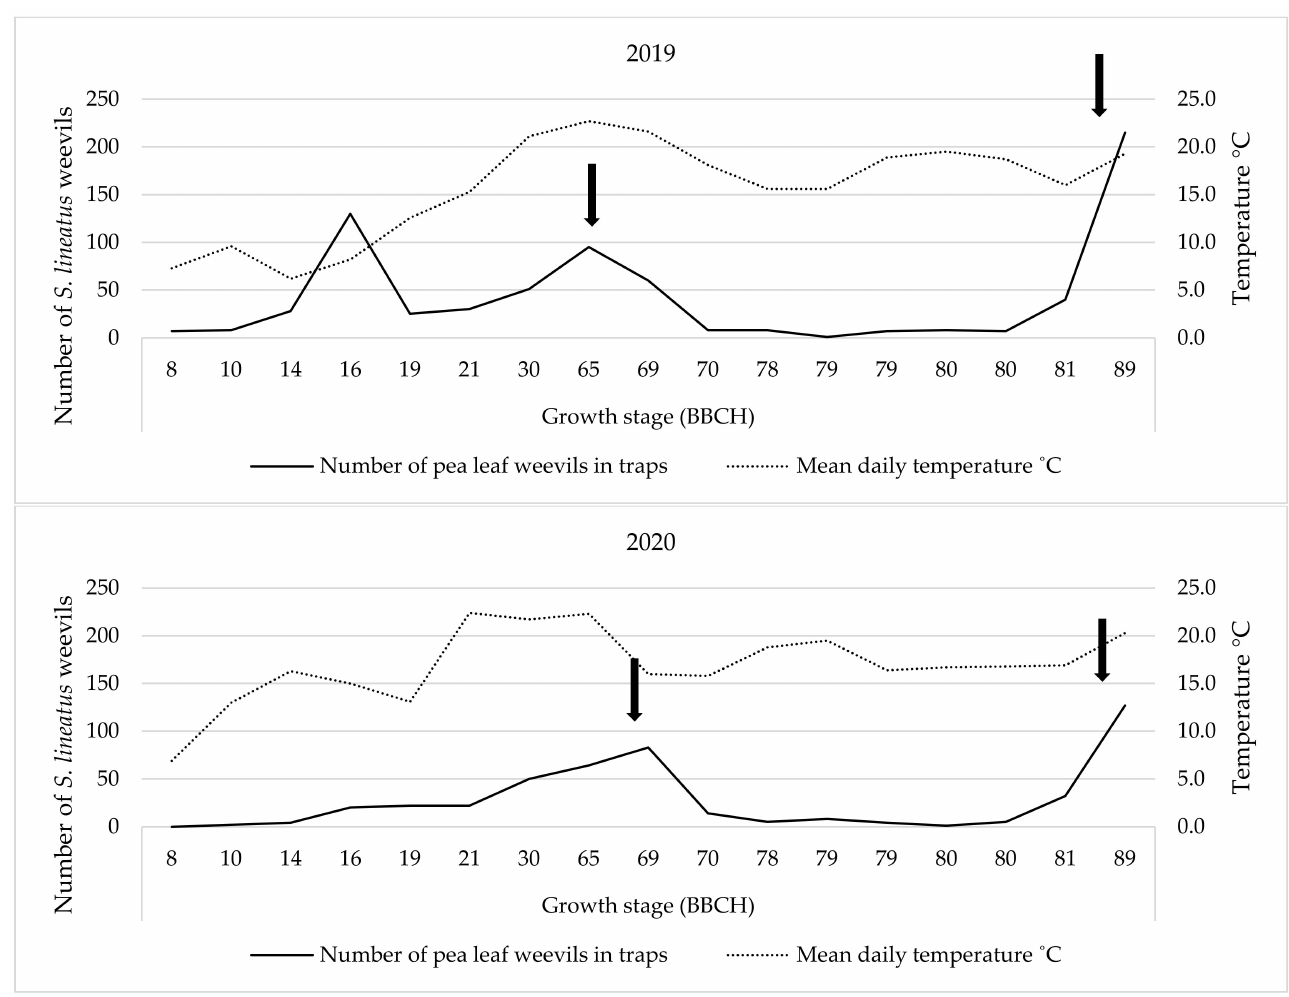
Figure 2. Numbers of Sitona lineatus adults captured in yellow water traps across growth stages of broad bean during 2019 and 2020 and mean daily temperatures. Note: Arrow on the left denotes flowering stage and the one on the right denotes full ripe